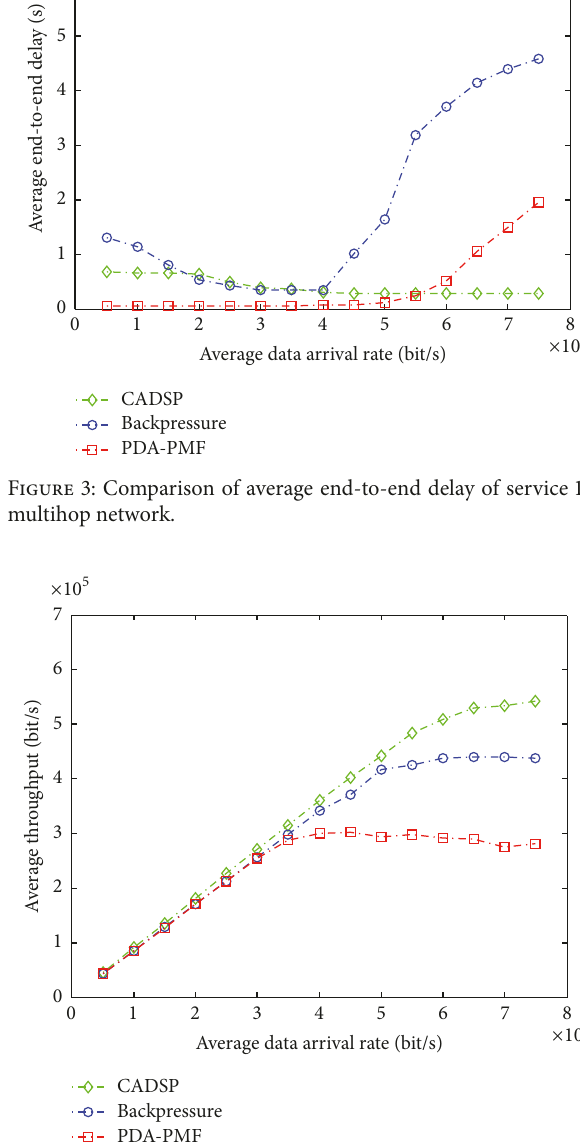
Figure 4: Comparison of average throughput of service 2 in multihop